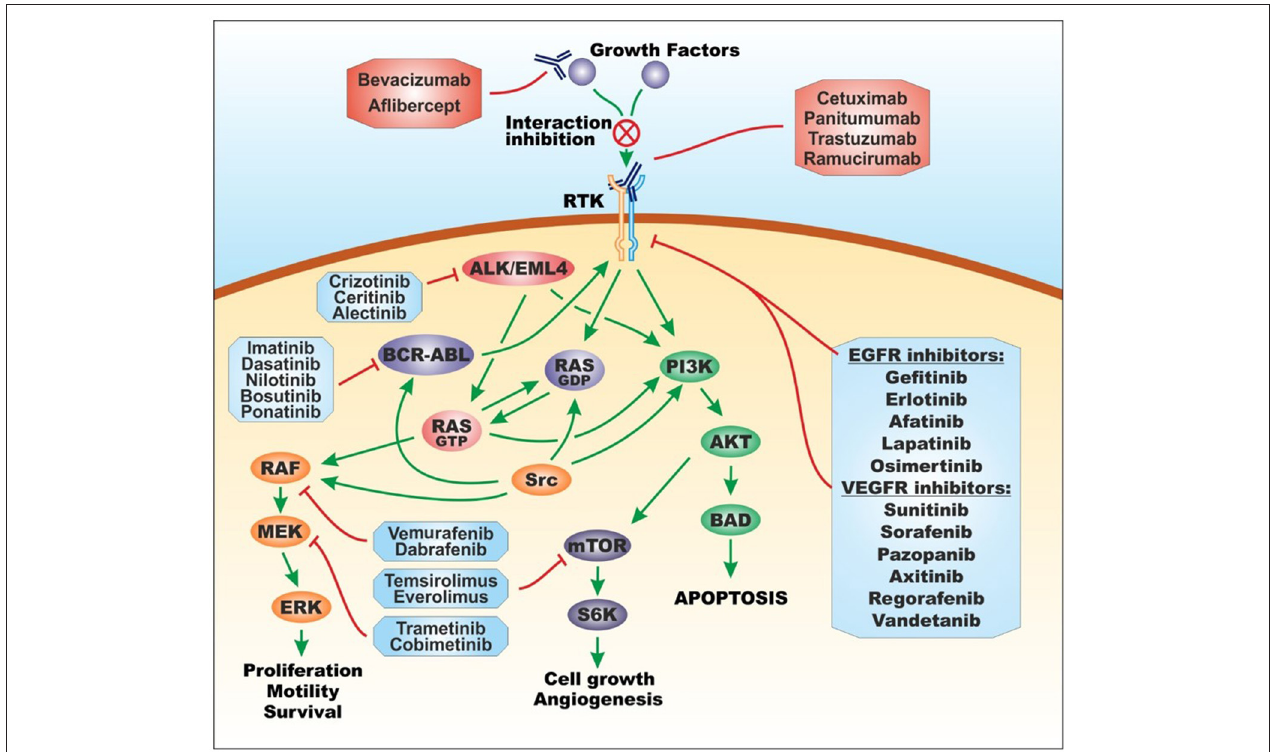
FIGURE 3 | Molecular targets of targeted therapy. Targeted therapy for cancer treatment is based on tyrosine and serine/threonine protein kinase inhibitors and monoclonal antibodies. Protein kinase inhibitors are divided into EGFR inhibitors, VEGFR inhibitors, BCR/ABL inhibitors, ALK/EML4 inhibitors, RAF inhibitors, MEK inhibitors, and mTOR inhibitors. Monoclonal antibodies are directed toward extracellular growth factors or extracellular receptor tyrosine kinase. Figure 3 has been adapted and enriched by taking a cue from two published papers by Massimo Libra, co-author of the present review (Russo et al., 2014; Leonardi et al., 2018). For the general structure of Figure 3 and the name of drugs, the information contained in the book “Farmacologia: Principi di base e applicazioni terapeutiche” was taken into account ( Rossi et al., 2016). ABL, Abelson murine leukemia viral oncogene homolog; AKT, protein kinase B; ALK, anaplastic lymphoma kinase; BAD, Bcl-2-associated death promoter; BCR, breakpoint cluster region; EGFR, epidermal growth factor receptor; EML4, echinoderm microtubule-associated protein-like 4; ERK, extracellular signal–regulated kinases; MEK, mitogen-activated protein kinase; mTOR, mammalian target of rapamycin; PI3K, phosphoinositide 3-kinase; RAF, rapidly accelerated fibrosarcoma kinase; RAS, RAS proto-oncogene GTPase; RTK, receptor tyrosine kinase; S6K, S6 kinase; src, proto-oncogene tyrosine-protein kinase Src; VEGFR, vascular endothelial growth factor